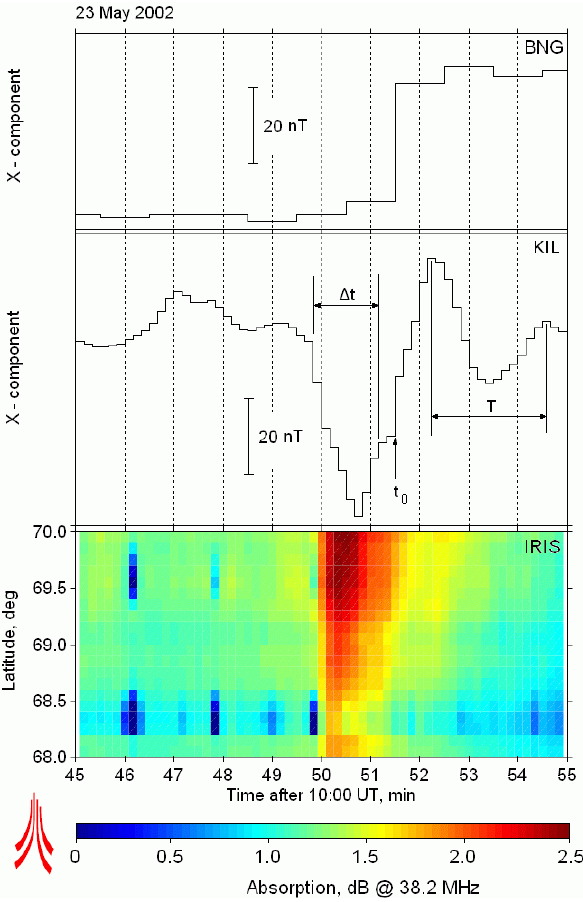
Fig. 11. Complex form of the SC-initiated magnetic disturbance. 1t is duration of preliminary impulse, t 0 indicates the time of ar- rival of the front of MHD-disturbance to the ionosphere, T is the period of